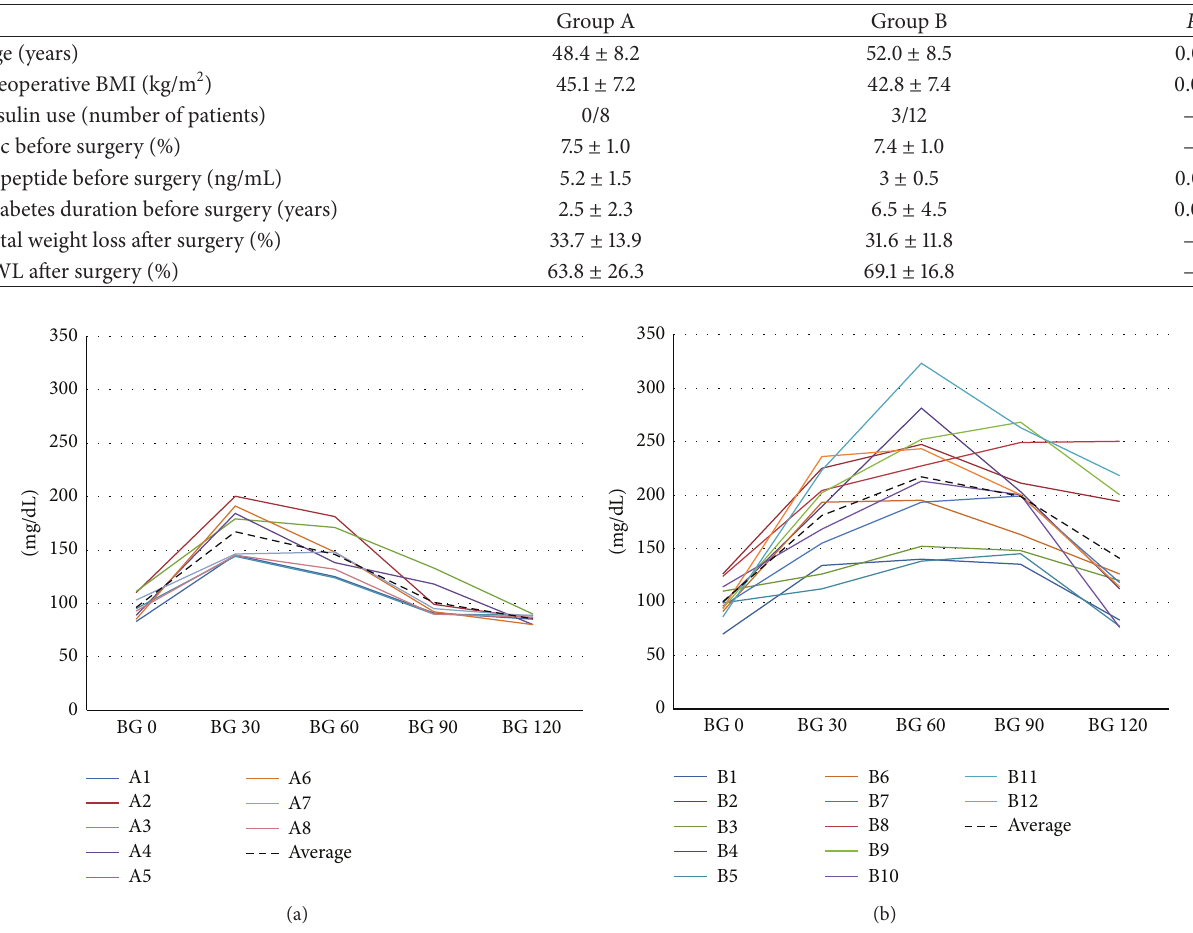
Table 3: Differences between group A and group B regarding age, BMI, insulin therapy, A1c, C-peptide, diabetes duration, and weight loss.